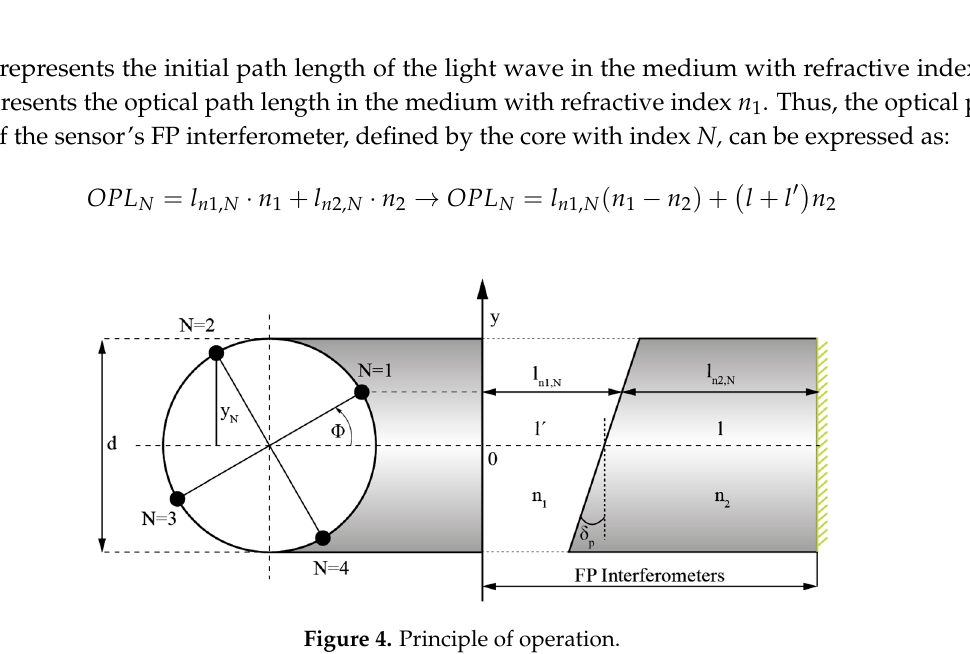
Figure 4. Principle of operation.